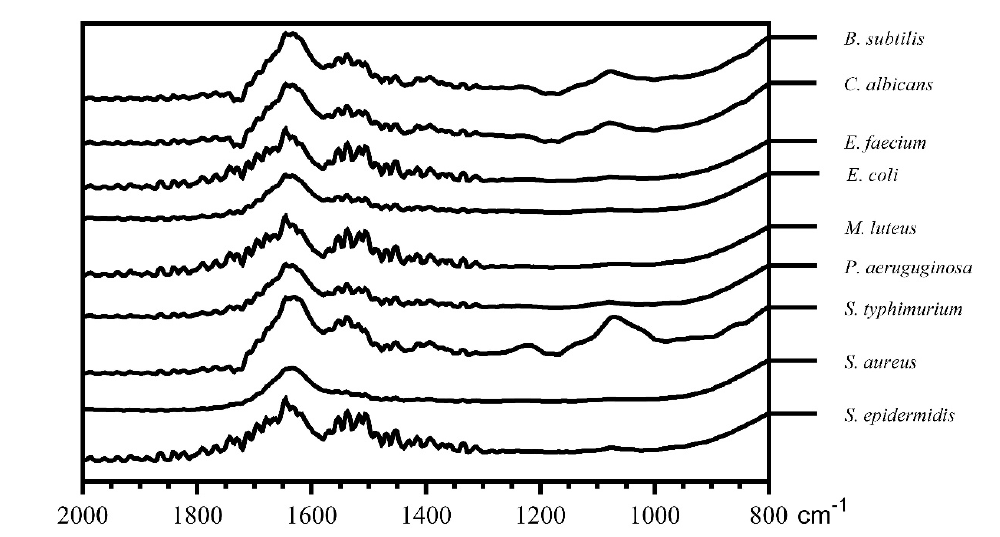
FIGURE 1 – FTIR-ATR spectra between 800 and 2000 cm -1 after first derivative and smoothing of Bacillus subtilis (ATCC 6633), Candida albicans (ATCC 10231), Enterococcus faecium (ATCC 8459), Escherichia coli (ATCC 8739), Micrococcus luteus (ATCC 10240), Pseudomonas aeruginosa (ATCC 9027), Salmonella typhimurium (ATCC 14028), Staphylococcus aureus (ATCC 6538), and Staphylococcus epidermidis (ATCC 12228) microbial